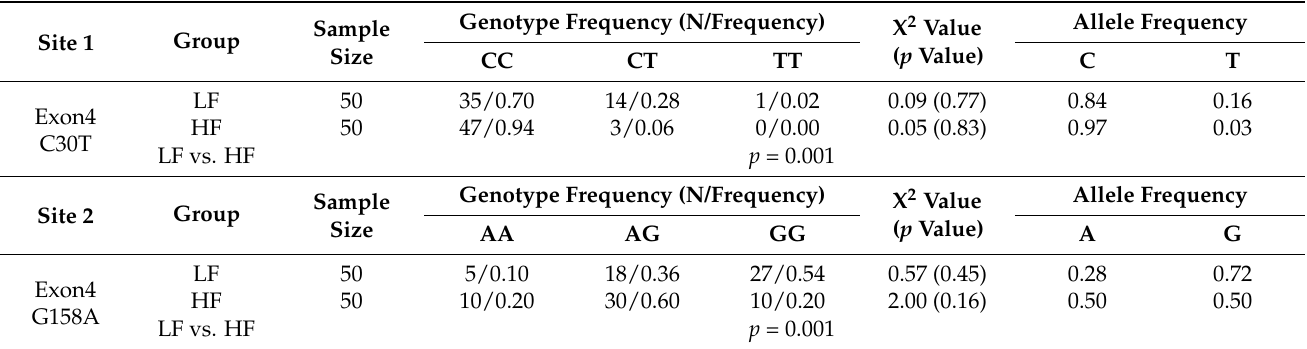
Table 4. Allele and genotype frequencies of MYOZ1 SNP locus of duck.